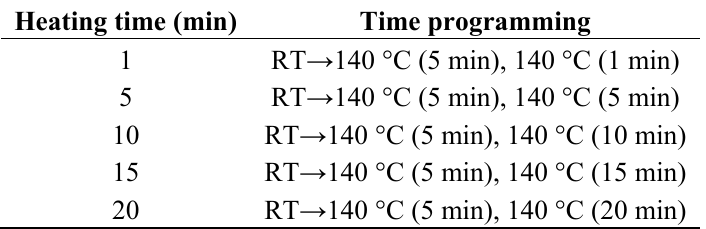
Table 2. Time programming of different set heating